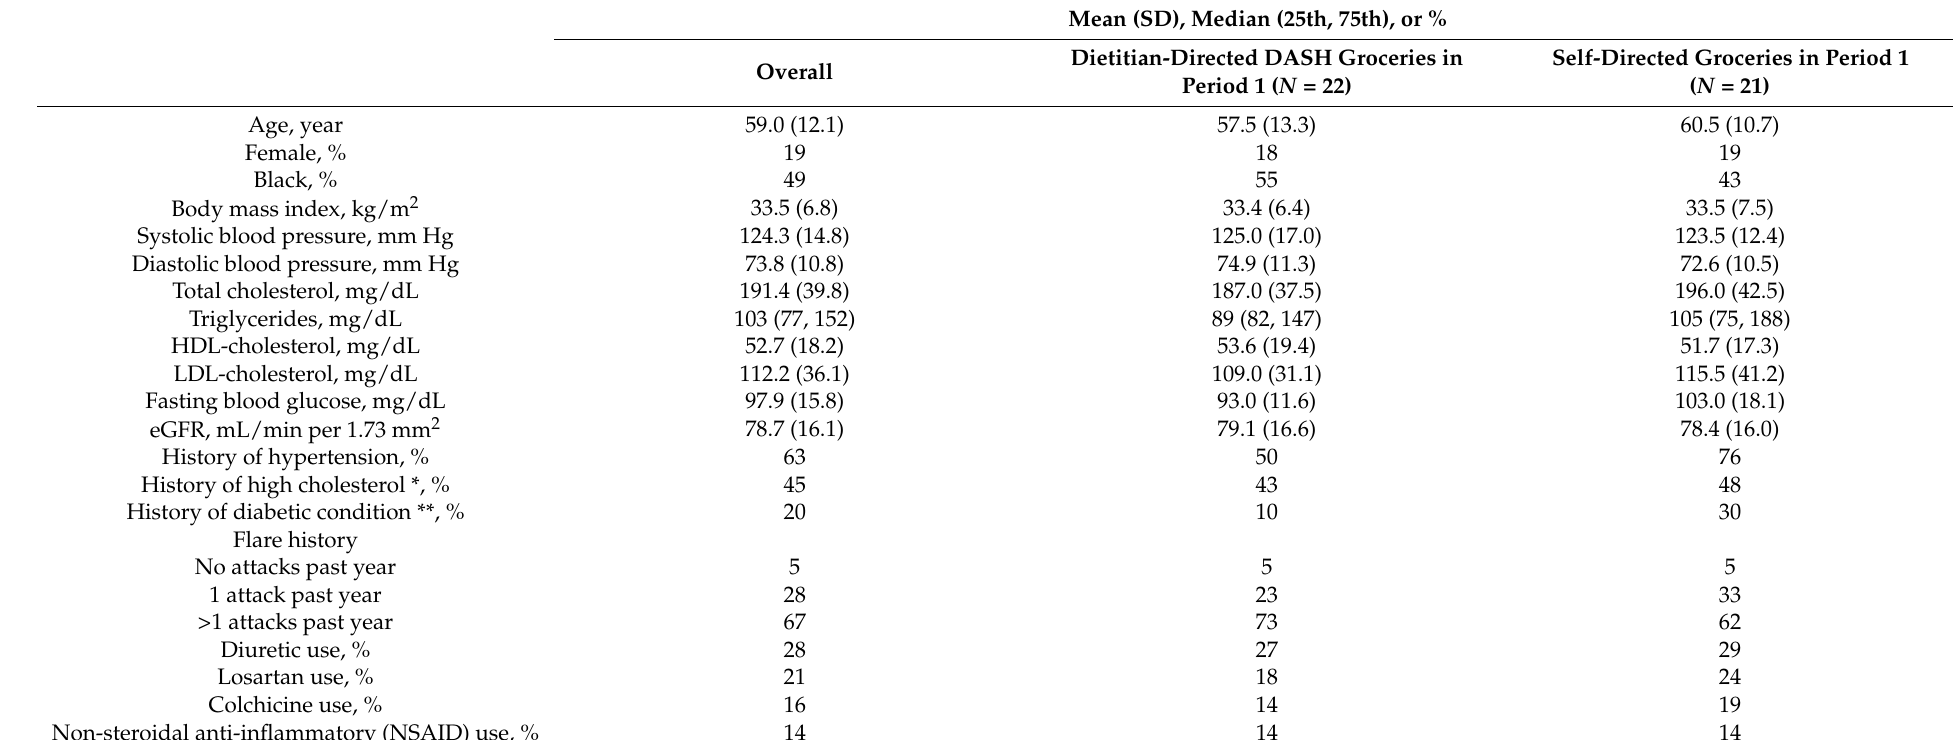
Table 2. Characteristics of enrolled participants, overall and by their assigned order of